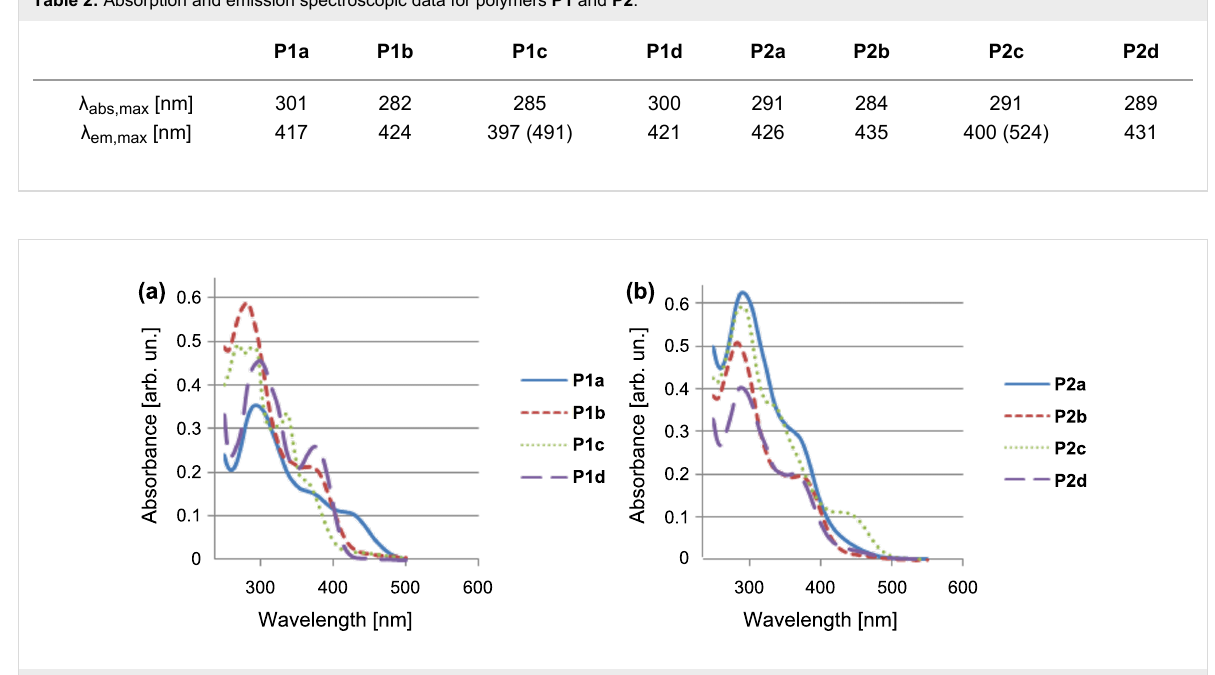
Table 2: Absorption and emission spectroscopic data for polymers P1 and P2 .